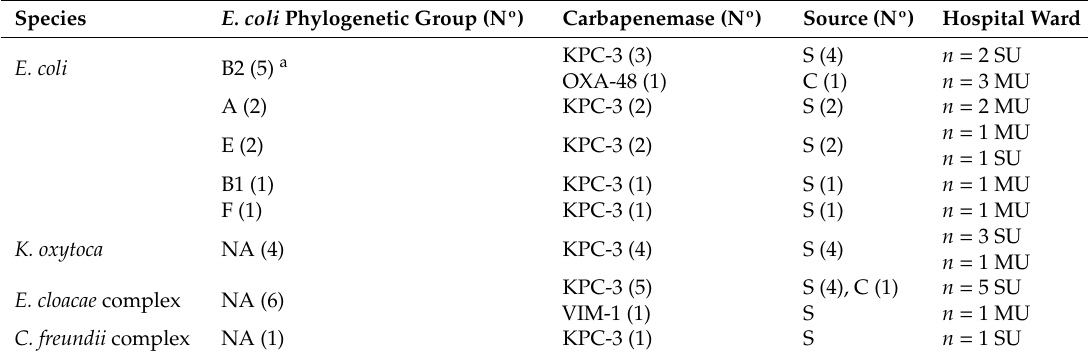
Table 4. Characterization of CPE producers other than K.